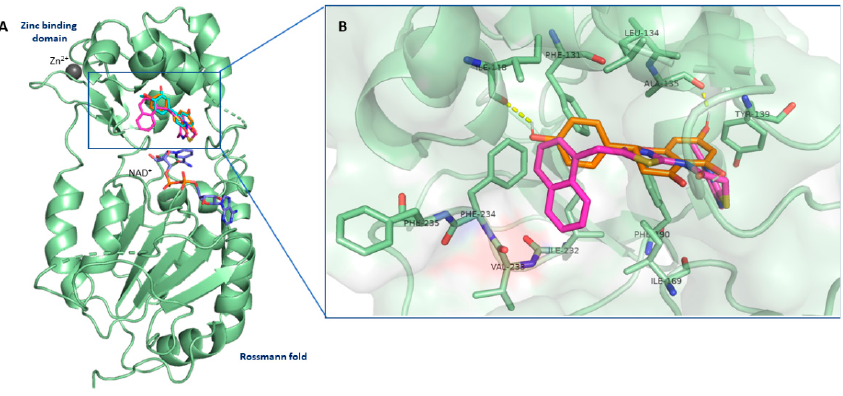
Figure 9. NAR and HSP interacted with the inhibitory site of SIRT2 in silico. ( A ) X-ray pose of SirReal2 (in magenta; PDB code 4RMG) superimposed on the predicted binding pose of NAR (in orange) and HSP (in cyan). ( B ) Interactions of SirReal2 and NAR at selectivity pocket of SIRT2. The crucial residues are shown in stick mode, while hydrogen bonds are shown as yellow dashed